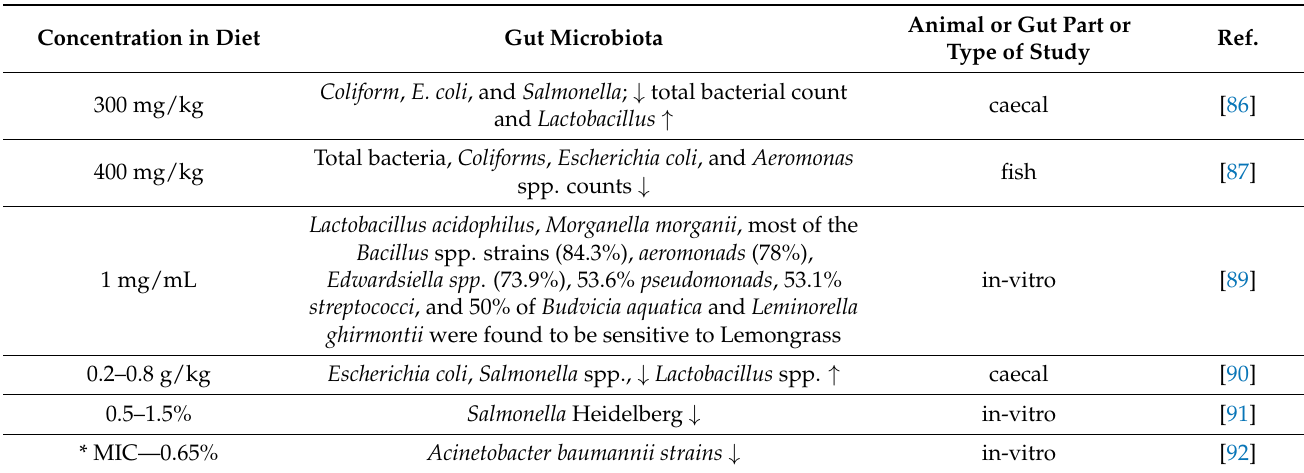
Table 3. Effect of lemongrass on gut